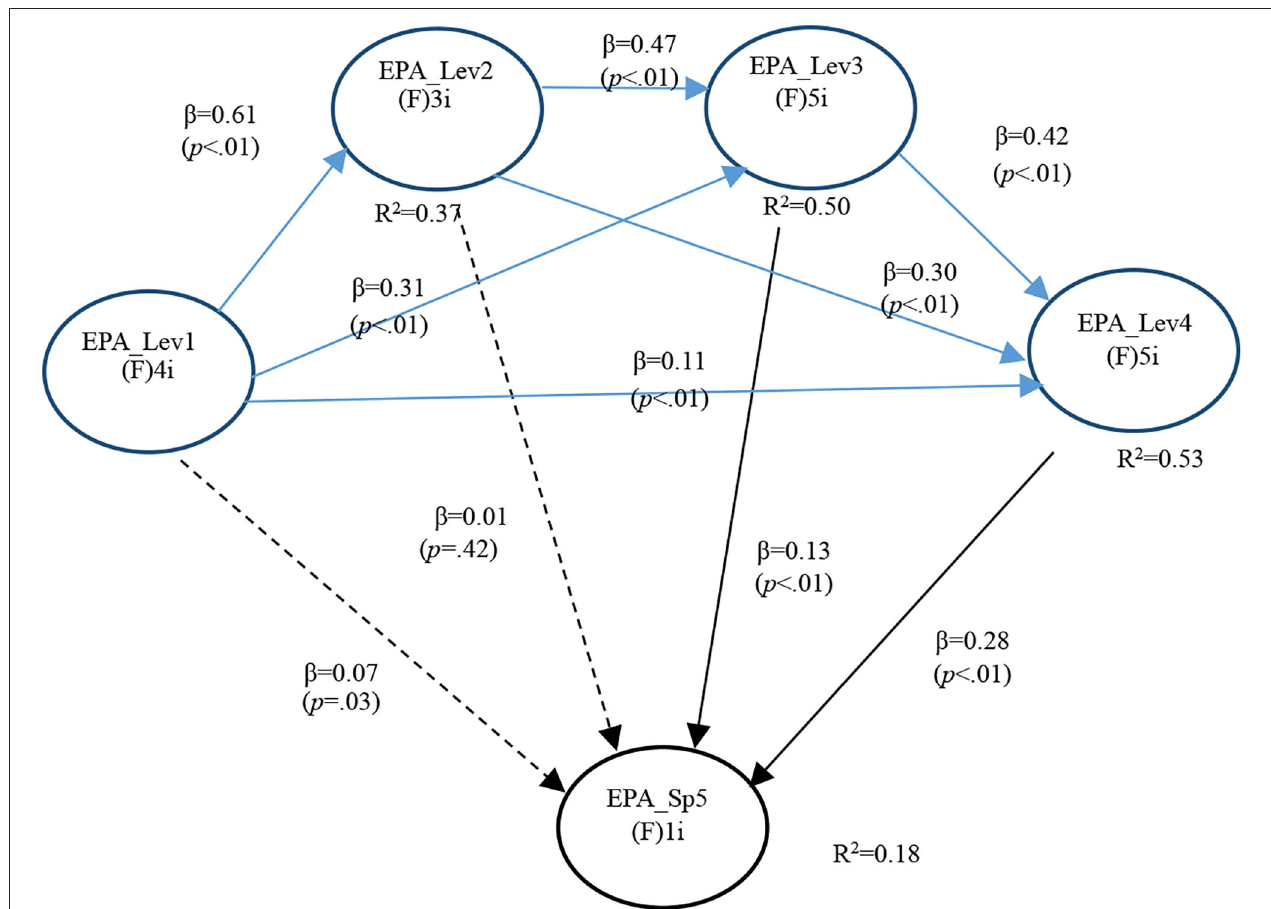
FIGURE 5 | Full model for GI EPA